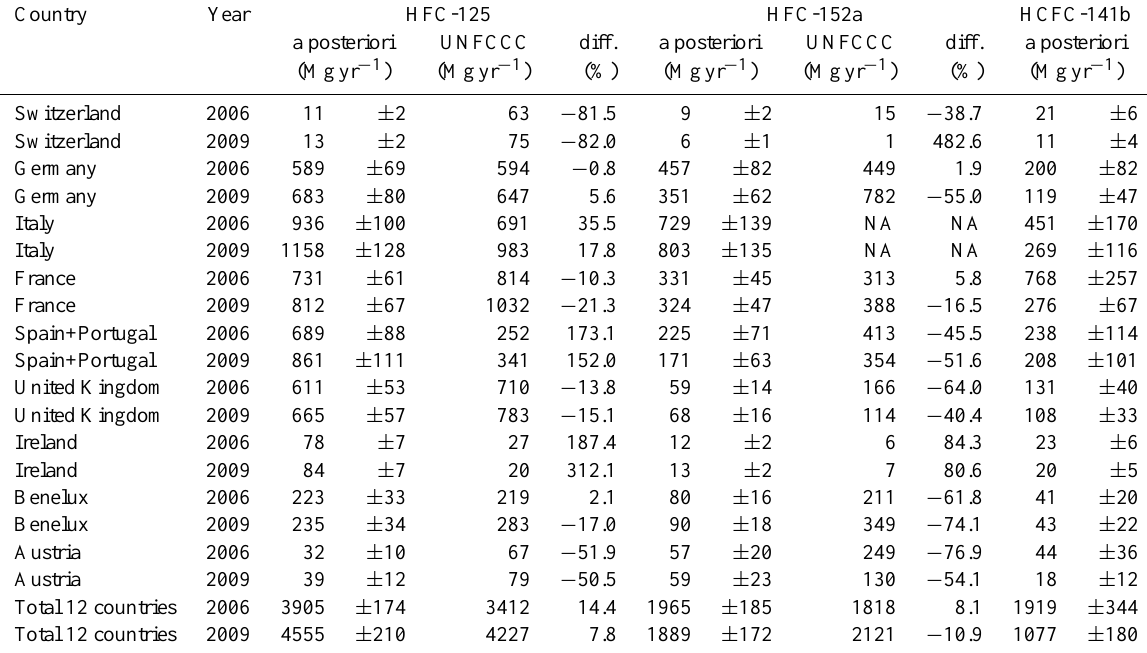
Table 5. Estimated country-specific emissions of HFC-125, HFC-152a and HCFC-141b. For HFC-125 and HFC-152a the UNFCCC bottom- up values are also provided for comparison. Although the inversion provides relative uncertainties due to the estimation of the logarithm of emissions, uncertainties are indicated as absolute errors (1 σ ) by multiplying the estimated emission by its relative uncertainty. For the total of all 12 countries the uncertainty was estimated as the mean squared